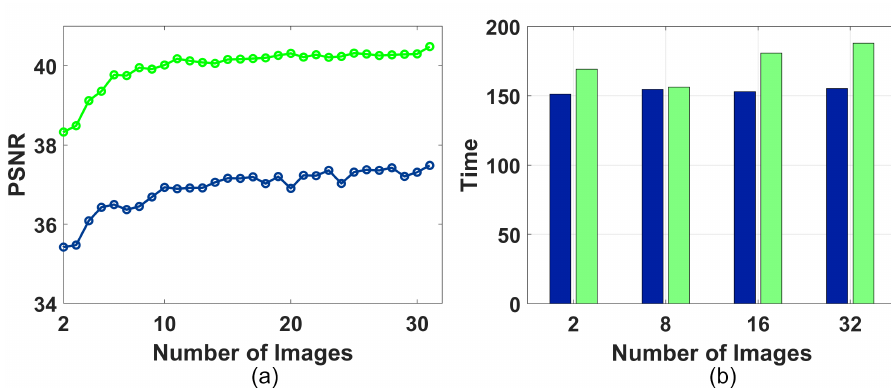
Figure 4. Results of the ASR2_m algorithm using an increasing number of input images for the test images I1 and I2. ( a ) PSNR versus the number of input images. I1: green dashed line; I2: blue continuous line. ( b ) Execution times in seconds. I1: green bars; I2: blue